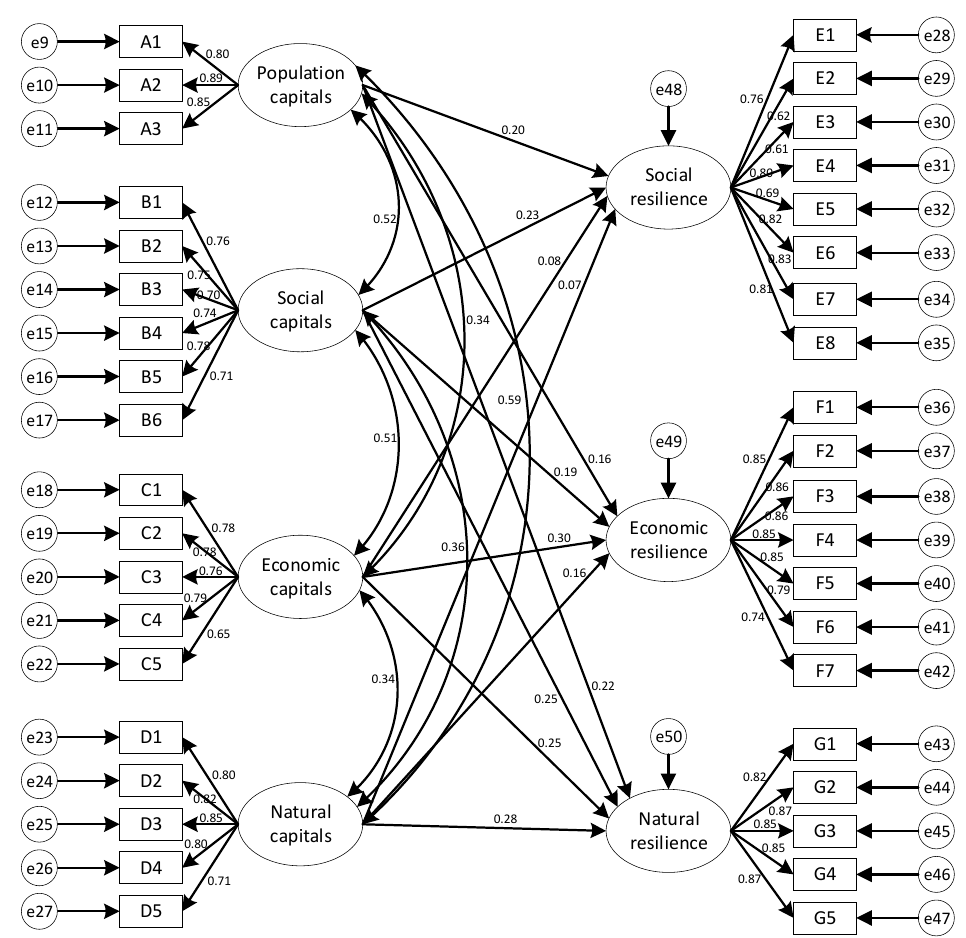
Figure 6. Equation model of structural equations for urban community waterlogging resilience in China.